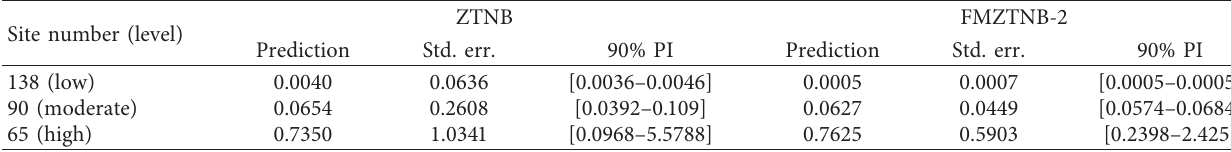
Table 4: Prediction comparison between ZTNB and FMZTNB models (three example